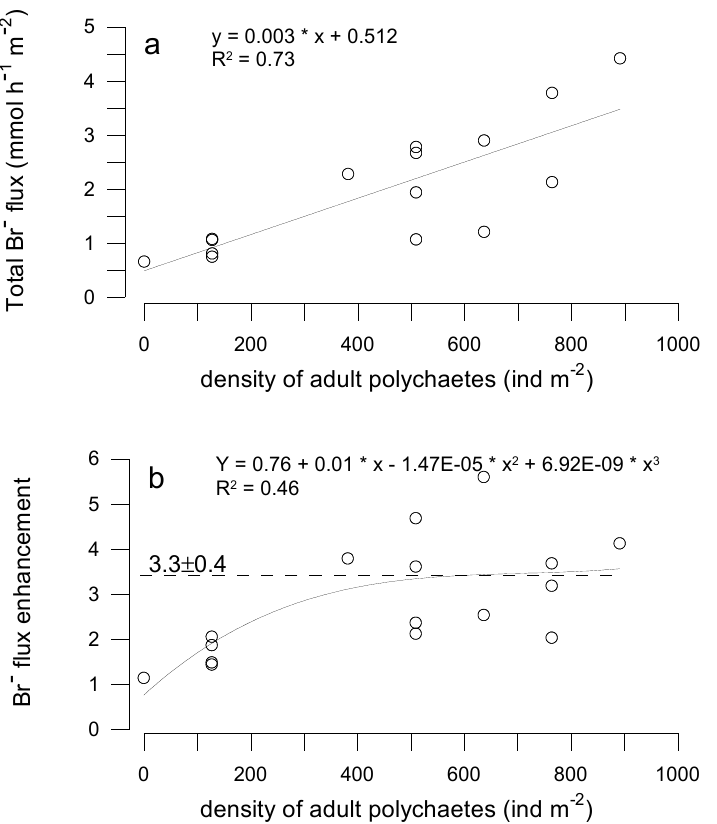
Figure 4. Total bromide flux ( a ) and tracer flux enhancement ( b ) vs. density of polychaetes found in the sediment after incubations. The horizontal dashed line denotes average flux enhancement estimated for the unmanipulated natural sediment.